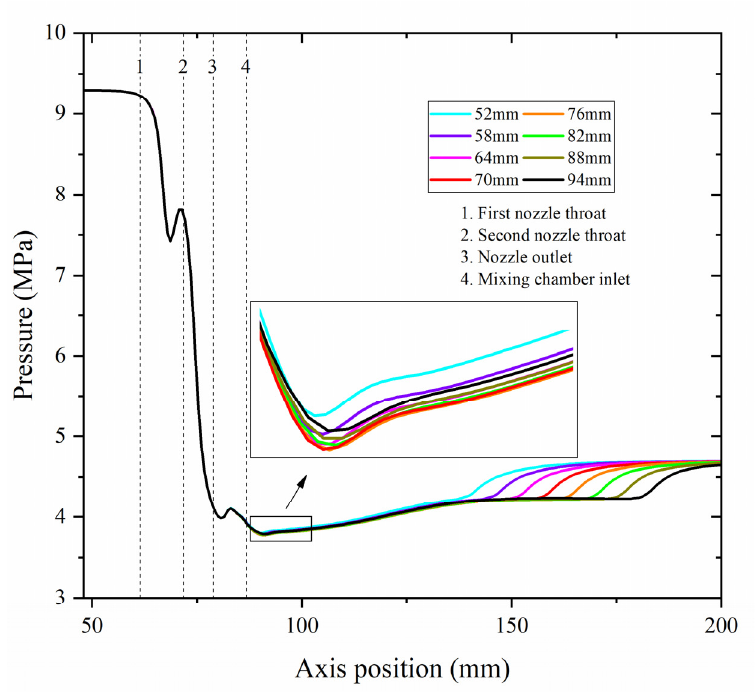
Figure 11. Variations of axial static pressures under different L m ( P p of 9.3 MPa).